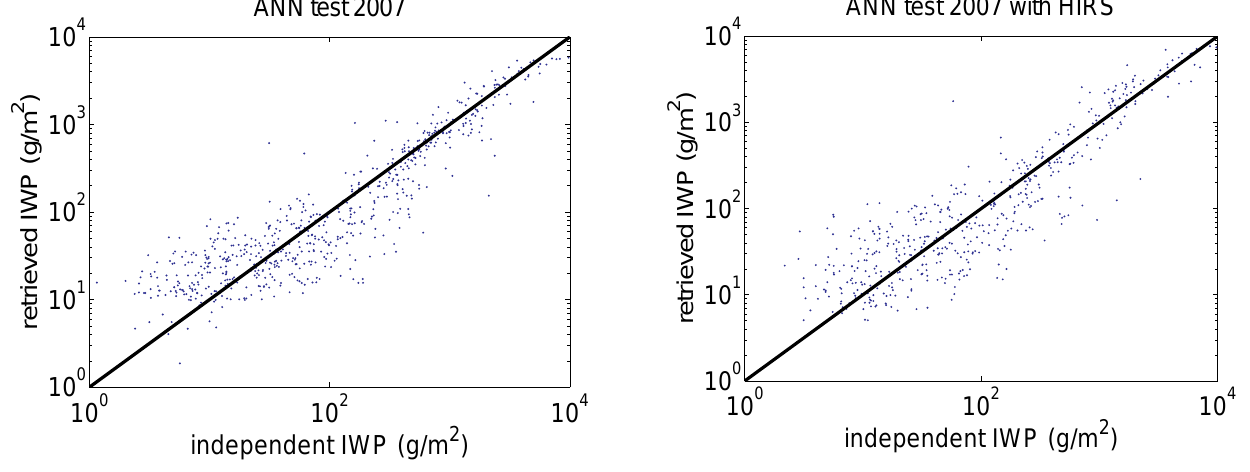
Fig. 12. Scatter plot to show the performance of the neural network, MHS 3–5, HIRS 8 and 11.